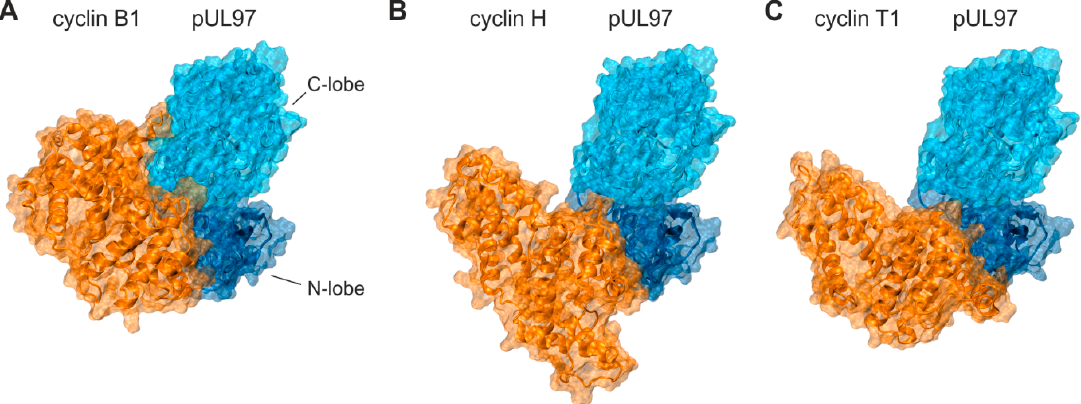
Figure 5. Differences in the interfaces between three types of human cyclins and the kinase domain of viral pUL97 suggested from molecular modeling. Kinase domain of pUL97 with its N ‐ lobe (dark blue) and C ‐ lobe (light blue) in complex with globular regions of: ( A ) cyclin B1; ( B ) cyclin H; and ( C ) cyclin T1. The three cyclins are colored in orange. Note that the globular region of cyclin B1 has contacts to both, the N ‐ and C ‐ lobes of the pUL97 kinase domain, whereas cyclins H and T1 exclusively bind to the N ‐ lobe. From a proteomic point of view, the sensitivity of state ‐ of ‐ the ‐ art nanoliquid chromatography and